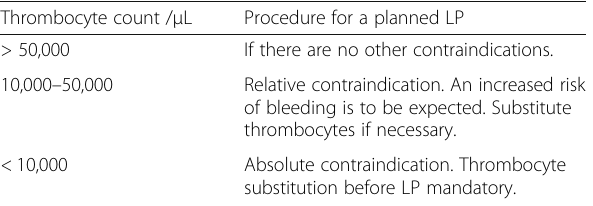
Table 2 Recommendations for diagnostic LP in thrombocytopenia (see also cross-sectional guideline of the Bundesärztekammer on therapy with blood components and plasma derivatives (https://www.bundesaerztekammer.de/ fileadmin/user_upload/downloads/pdf-Ordner/WB/QLL_